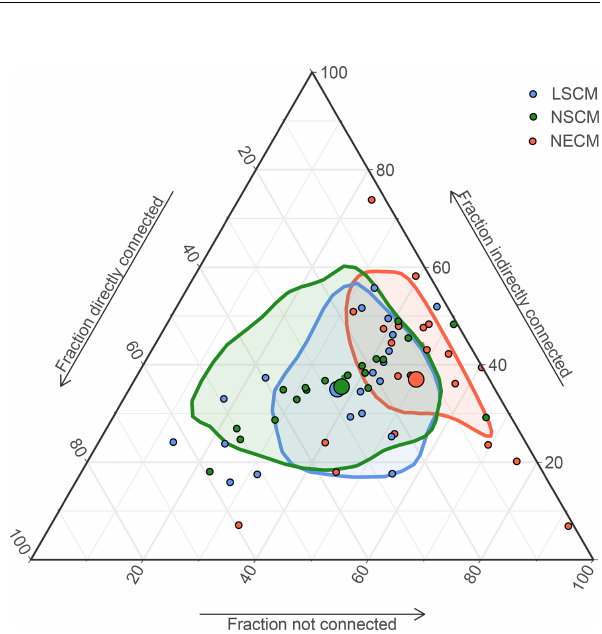
Figure 7. Fractions (%) of directly connected ( f dir ), indirectly con- nected ( f indir ), and not connected areas ( f nc ) per total agricultural area for the local surface runoff connectivity model (LSCM; blue), national erosion connectivity model (NECM; red), and national sur- face runoff connectivity model (NSCM; green) in the 20 study ar- eas. Small blue circles represent the catchment medians of all Monte Carlo simulations of the LSCM, small red circles represent the data reported by the NECM, and small green circles represent the catch- ment medians of the NSCM. Large circles represent the means of the LSCM (blue), NECM (red), and NSCM data (green). Shaded ar- eas represent normal kernel density estimates of the LSCM, NECM, and NSCM